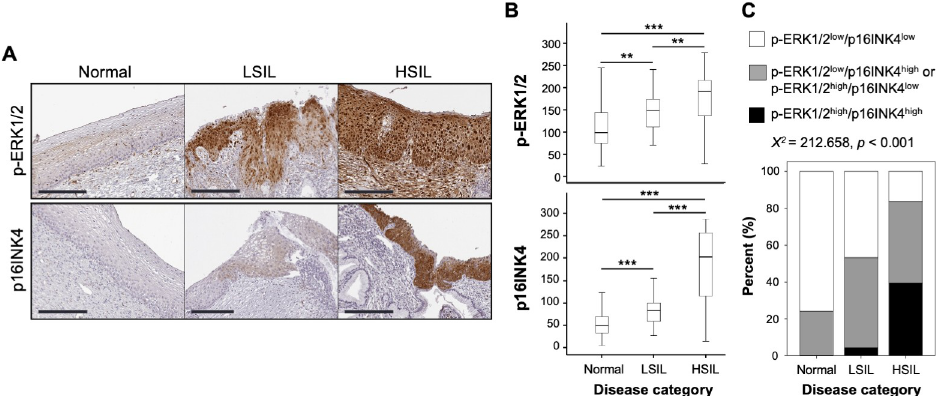
Fig 1. Correlation of p-ERK1/2 and p16INK4 expression in human cervical intraepithelial neoplasia specimens. (A) Representative IHC staining images of p16INK4 (p16) and p-ERK1/2 in normal, LSIL, and HSIL specimens. Bars equal 200 μ m. (B) Box plot depiction of IHC scores; center tendency and variability. IHC scores for p-ERK1/2 and p16INK4 expression levels were significantly increased according to disease progression from normal to LSIL to HSIL ( �� p < 0.01 and ��� p < 0.001 correspond to the non-parametric Kruskal-Wallis/Mann–Whitney U tests). (C) The combined expression of p-ERK1/2 and p16INK4 was compared among normal, LSIL, and HSIL samples (see